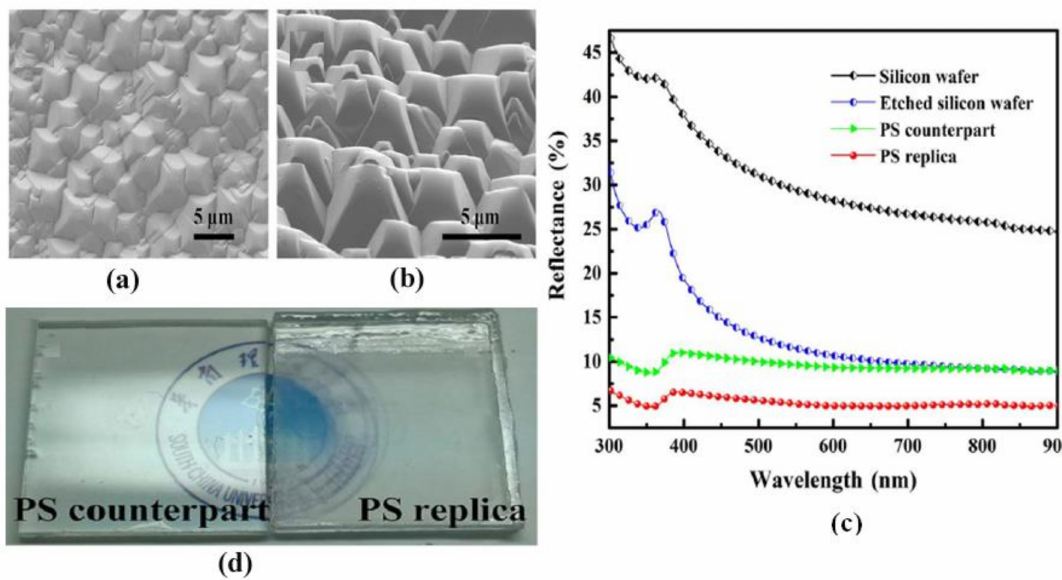
Figure 22. ( a ) Top and ( b ) tilted views of PS replica molded by micro-ICM (SEM images). ( c ) Comparison ofreflectancespectraofsiliconwafer, etchedsiliconwafer, PScounterpart, andPSreplica. ( d )Photograph of PS replica and PS counterpart exposed to white fluorescent light. Reprinted with permission [6]; 2017,